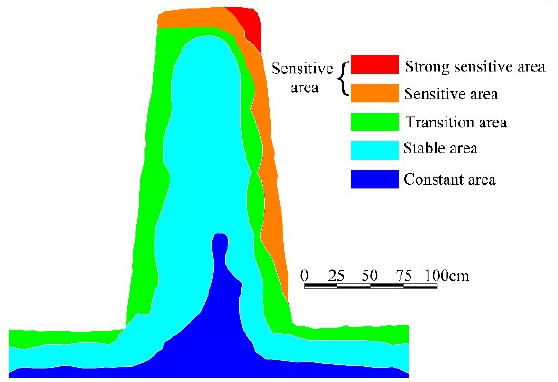
Figure 29. Temperature field of test wall across one